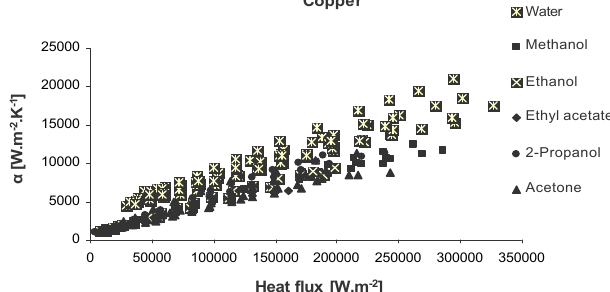
Fig. 3. The effect of heat transfer level on the heat transfer coefficient rate of pure